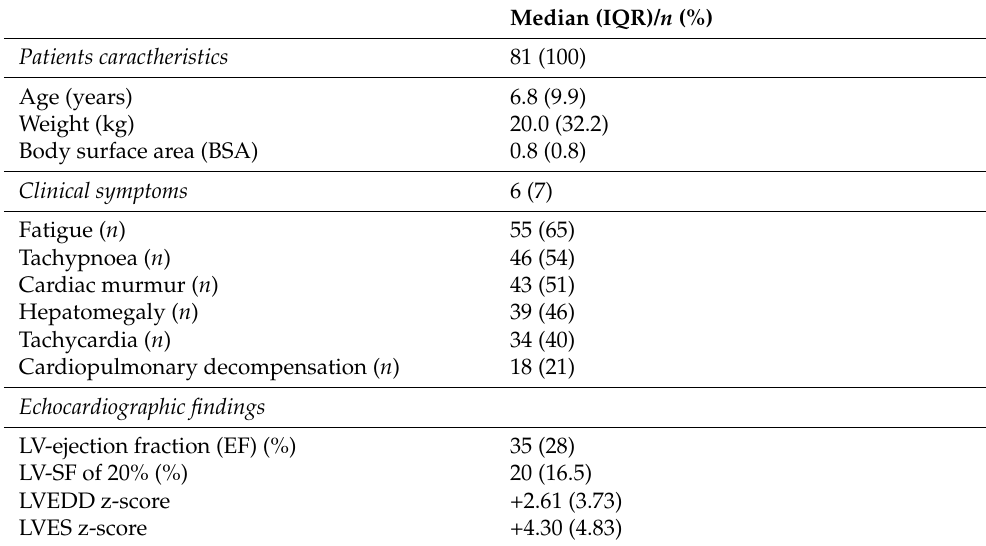
Table 1. Clinical and echocardiographic findings at hospital